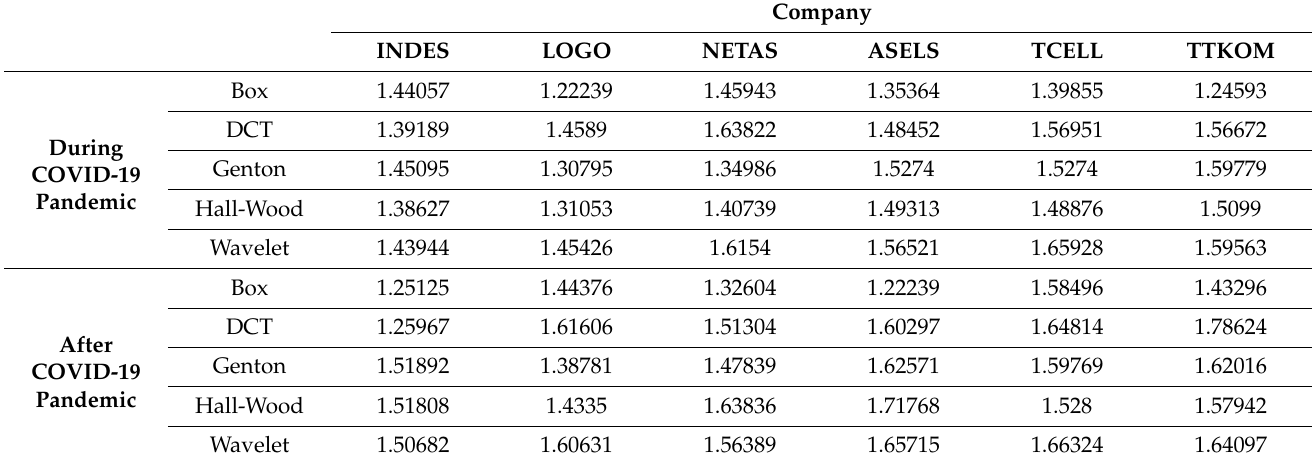
Table A12. Fractal dimensions for the technology sector.